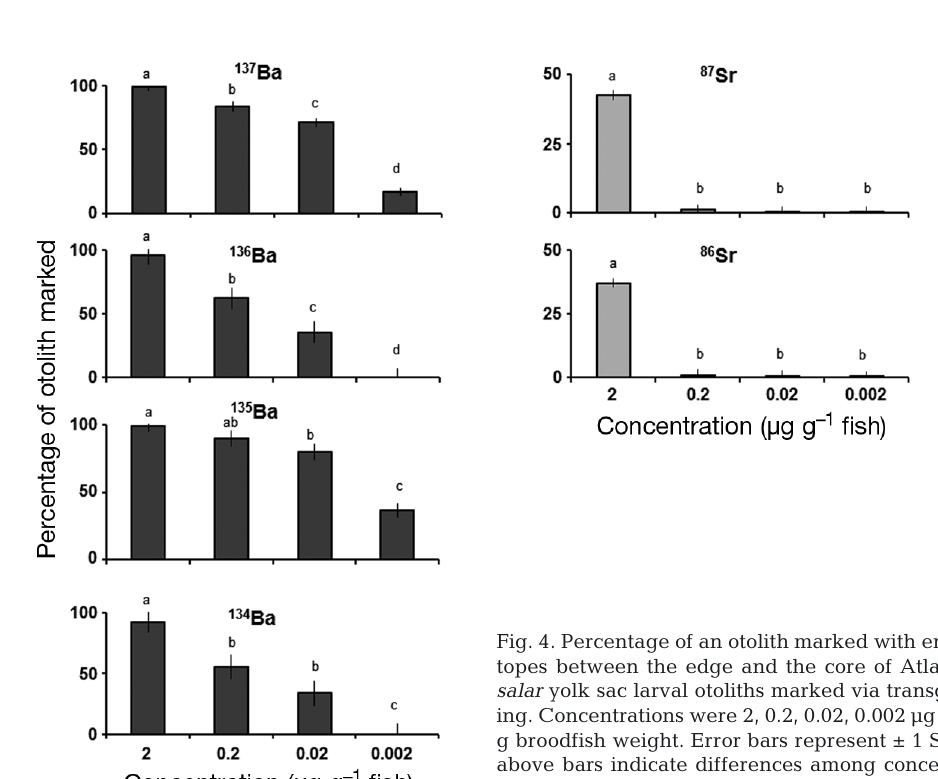
Fig. 3. Maximum observed isotope ratios in the otoliths of Atlantic salmon Salmo salar yolk sac larvae marked via transgenerational marking categorized by number of weeks between injection date and spawning date. Error bars represent ± 1 SE. Different letters above bars indicate differences among concentrations based on pairwise comparisons (p < 0.05). Dashed line shows natural ex- pected ratio for each isotope